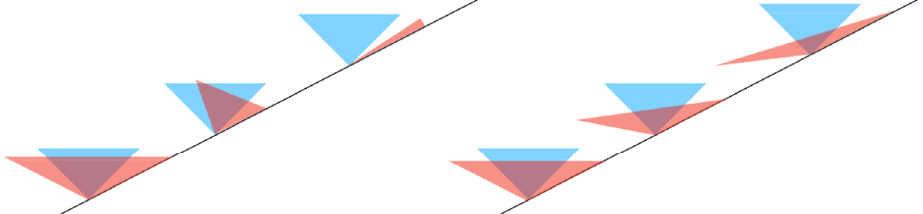
Figure 3 . Future causal cones for normal matter with speed of propagation c = 1 (blue) and the cubic galileon (red) for a right-moving superluminal simple wave, prior the caustic formation. The evolution of the causal cone is shown along the right-directed characteristic (cid:4) + = (cid:24) + . The left picture corresponds to the case of negative (cid:13)(cid:30) 00 , while the right picture is for positive (cid:13)(cid:30) 00